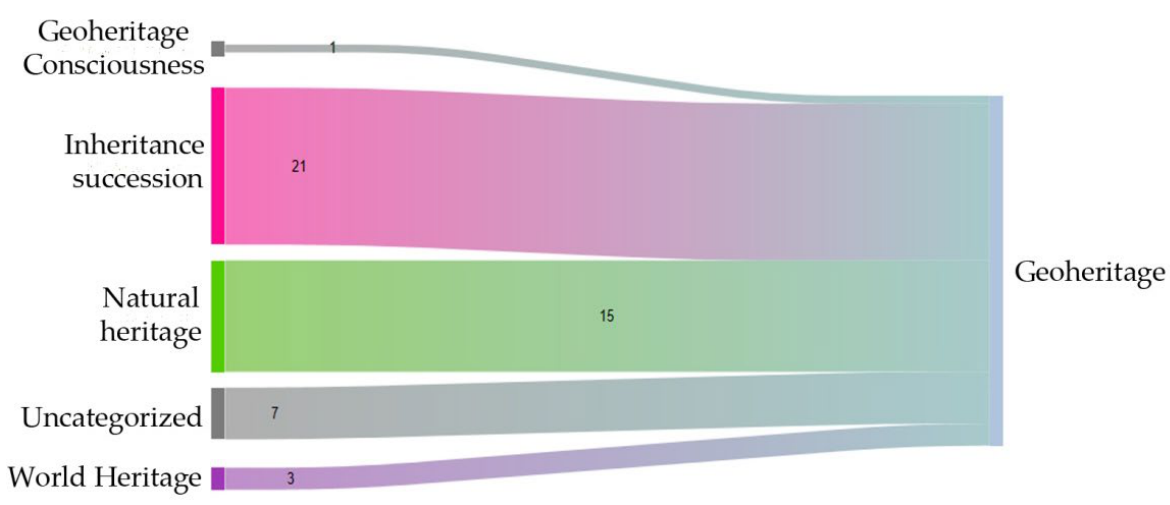
Figure 5. Graph of students’ perceptions (codes) on the concept of geoheritage (Sankey diagram).